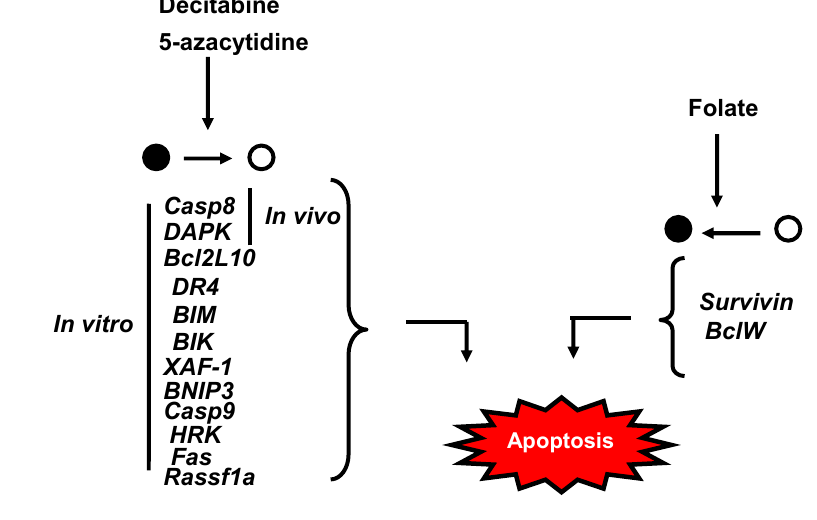
Figure 3. DNA methylation and anti-apoptotic strategies ( a ) Effects of both DNA demethylating agents and pro-methylation, mediated by folate, on apoptosis-related genes and apoptosis. ( b ) Conflicting results of demethylated agents and specific strategies against targeted DNA methylation on